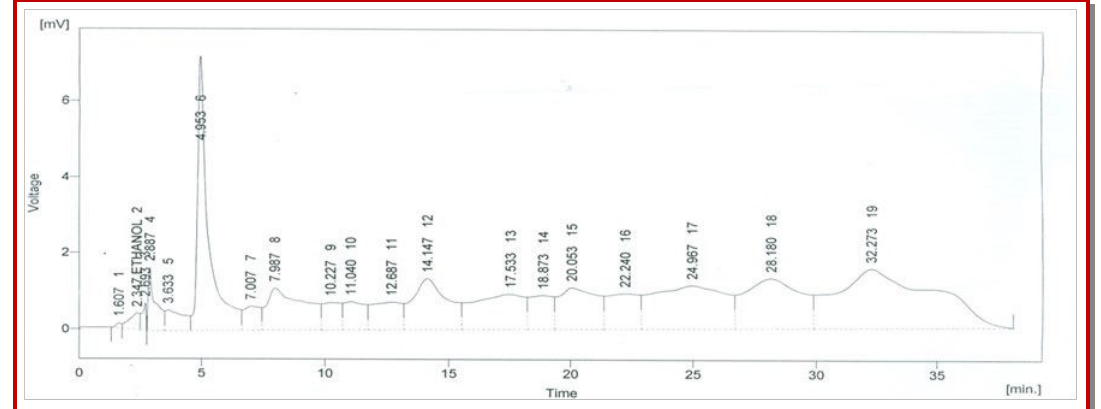
Figure 3: HPLC analysis of aqueous methanolic extract of Mentha